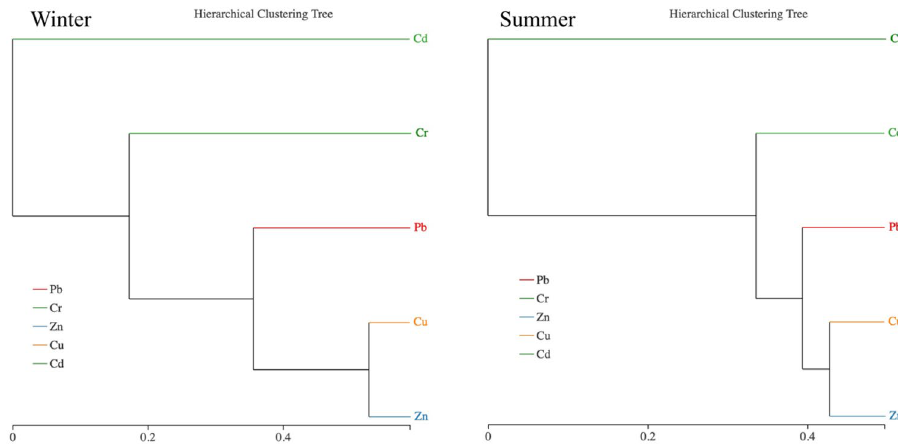
Fig. 10 Cluster analysis results of heavy metals in surface